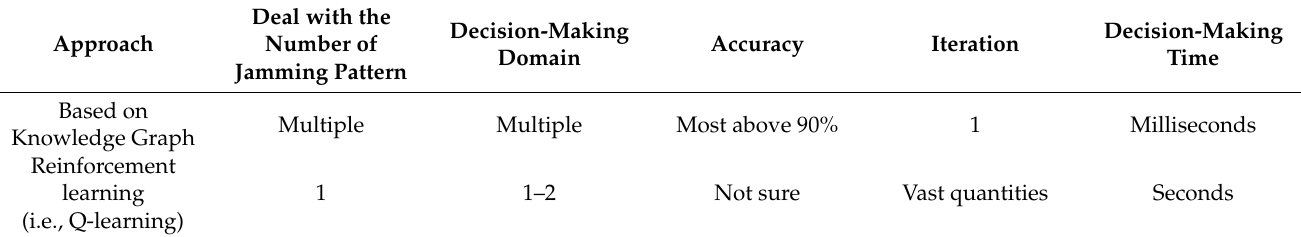
Table 5. Comparison with existing